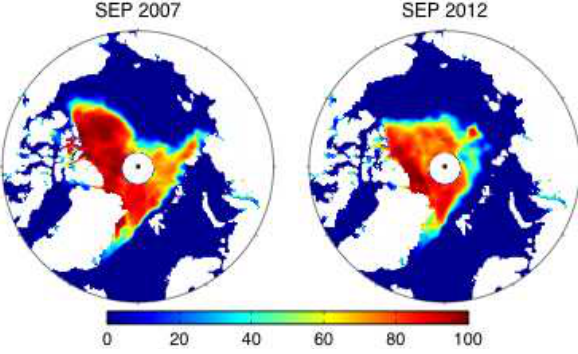
Fig. 1. Monthly mean sea ice concentration (contours [%]) for Fig. 1: Monthly mean sea ice concentration (contours [%]) for the September of 2007 and September 2007 and 2012. Sea ice concentration data are taken 2012. Sea ice concentration data are taken from the Nimbus-7 SMMR and DMSP SSM/I- SSMIS Passive Microwave dataset using Platform F13 and near-real time Platform F17 from the Nimbus-7 Scanning Multichannel Microwave Radiometer (Cavalieri et al. 1996). (SMMR) Defense Meteorological Satellite Program (DMSP), Spe- cial Sensor Microwave/Imager (SSM/I), Special Sensor Microwave Imager/Sounder (SSMIS). Passive Microwave data set using Plat- form F13 and near-real-time Platform F17 (Cavalieri et al.,